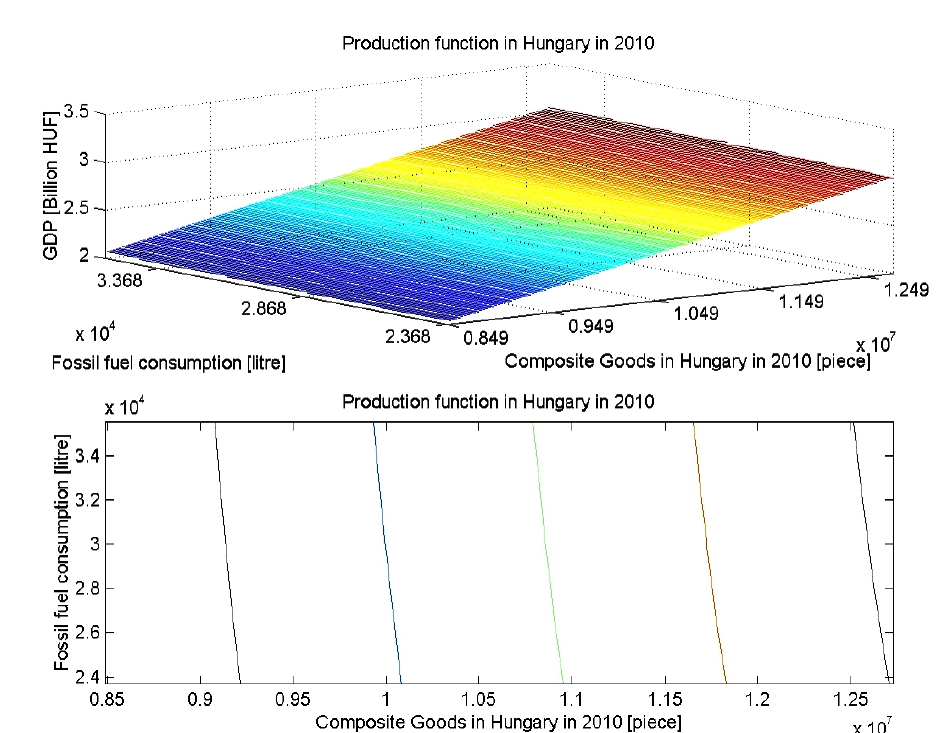
Figure 1. Visualisation of Cobb-Douglas production function (source: own modelling).